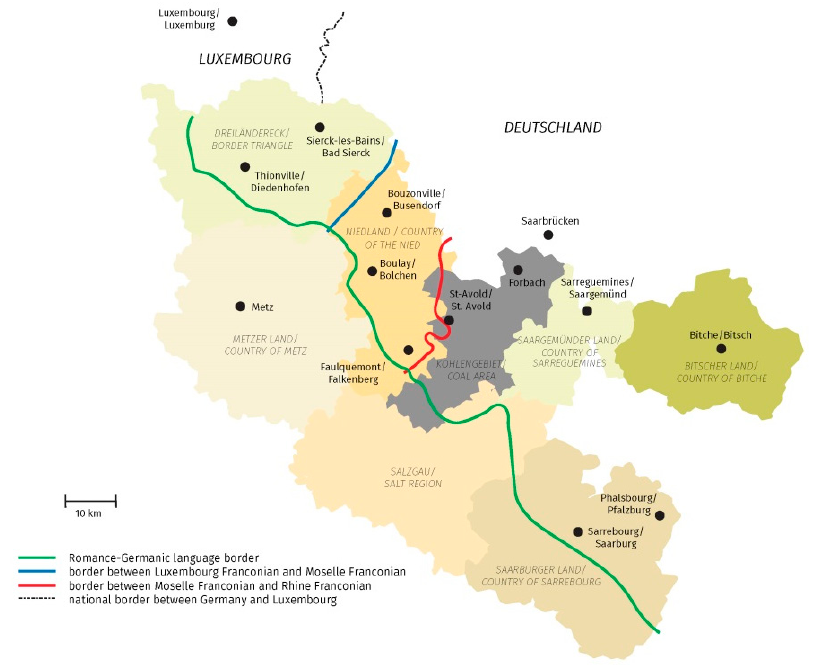
Figure 1. Linguistic and administrative subdivision of the departement Moselle (Lorraine/France) © IDS/Cußler-Volz.